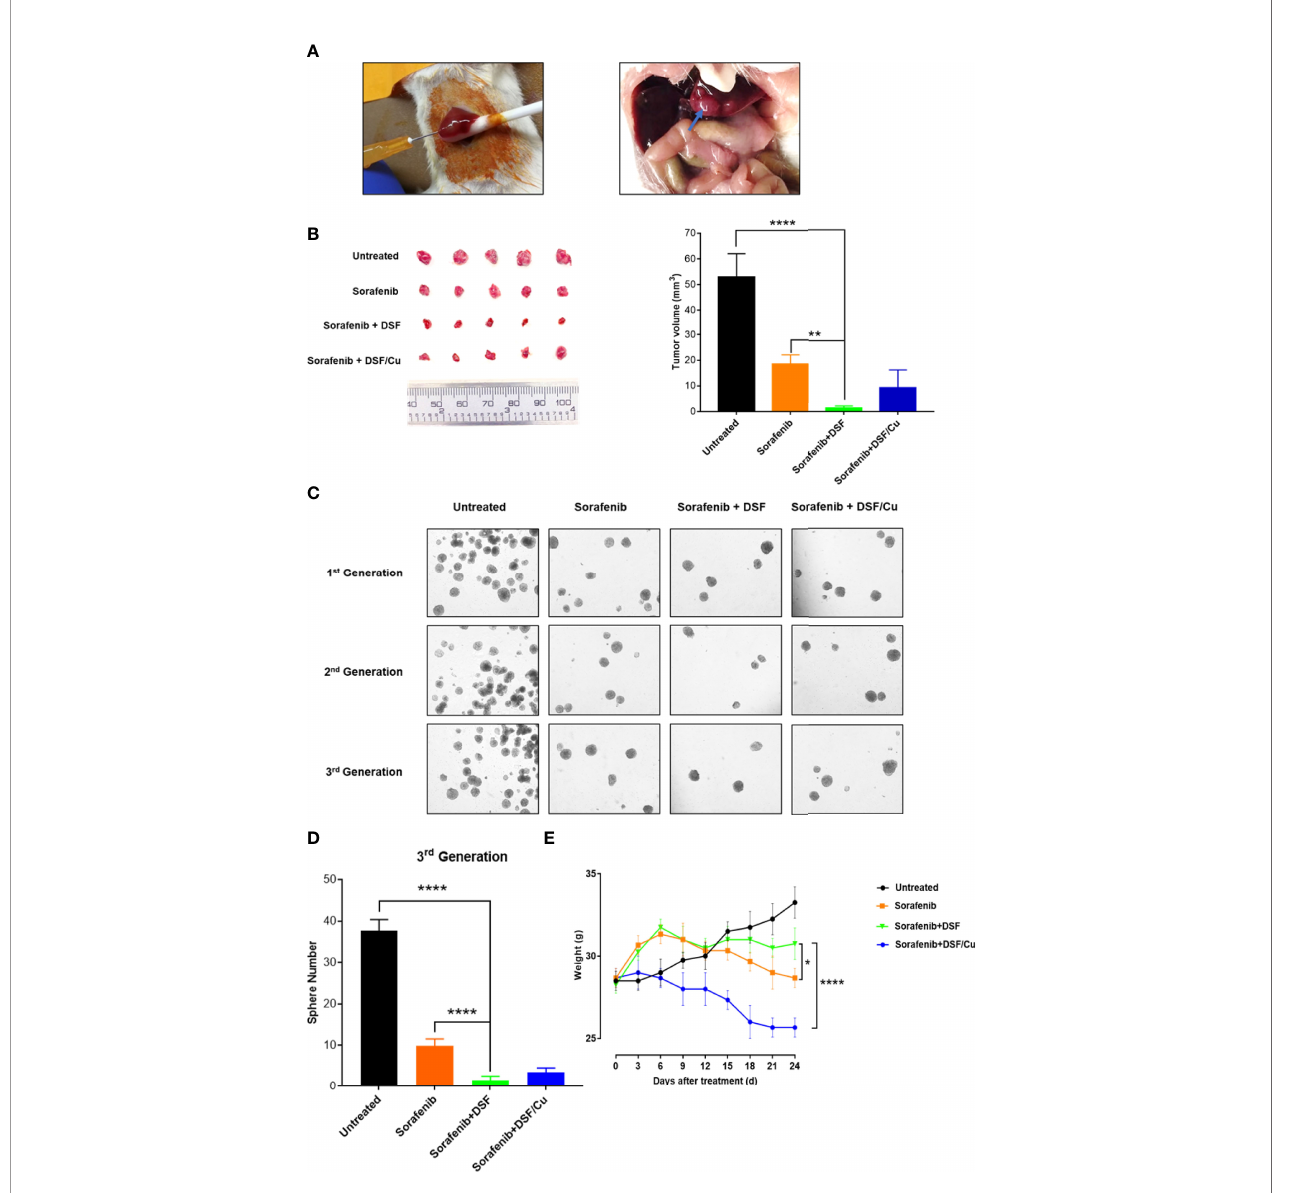
FIGURE 6 | DSF with endogenous Cu 2+ and sorafenib inhibits the growth of orthotopic HCC xenografts in mice more effectively than sorafenib alone. Human HepG2 cells were injected directly into the liver of NSG mice (left) and the resulting orthotopic liver tumor formation (right). (A) . Mice were grouped and all the treatments were initiated (on day 4). At the time of sacri fi ce (on day 24), tumors were resected and measured (B) . The sphere formation of cells isolated from the cells collected from xenograft tumors of each mouse group was assessed. Spheres were quanti fi ed by counting sphere numbers/well on day 14 (C, D) . To monitor toxicity, mouse body weight was measured every 3 days (E) . Data are shown as mean ± SD. *p<0.05, **p<0.01,